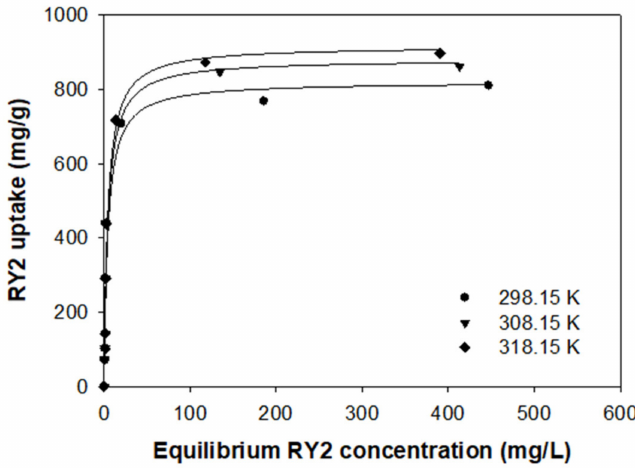
Figure 7. Adsorption isotherms of RY2 on the PEI/PVC-CF at different temperatures (experimental conditions: m = 0.02 g, V = 30 mL, C i range = 100–1000 mg/L, and pH = 2.0).